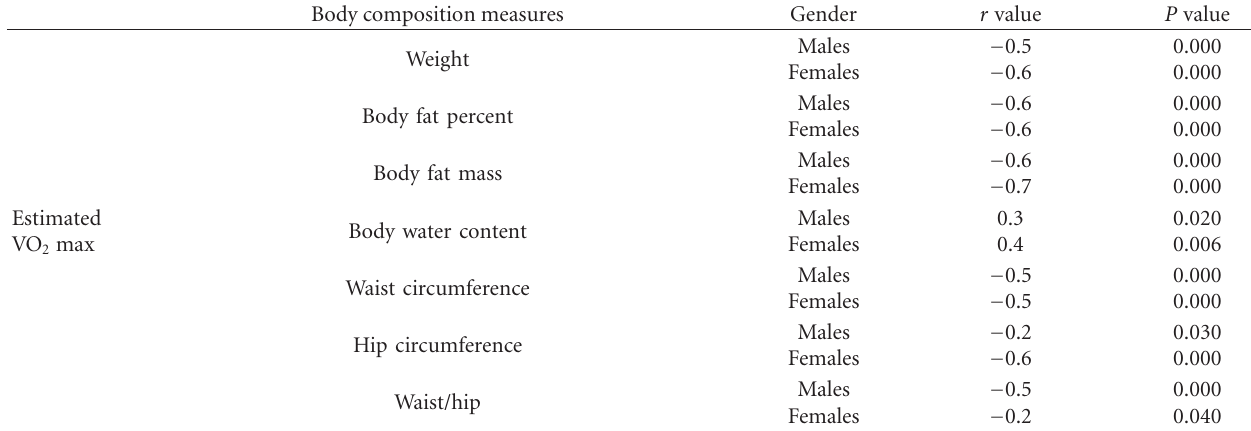
Table 3: Estimated maximum VO 2 relationship with body composition measures in the males and females.